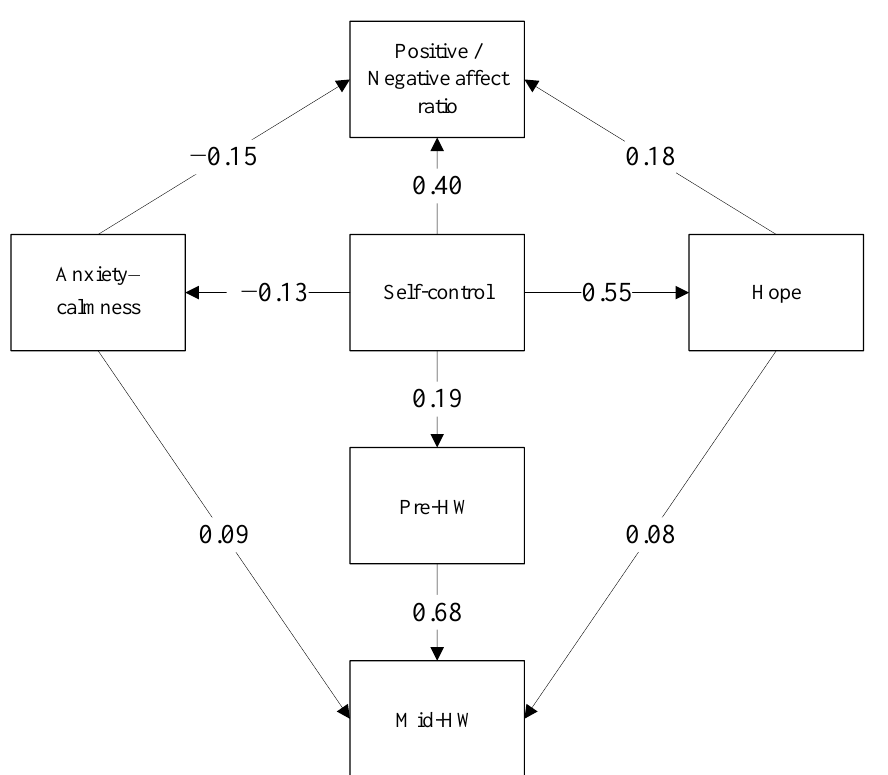
Figure 1. The mediation model linking self-control skills to personal resources, epidemic-related anxiety, and handwashing (HW) habits. Standardized regression weights are presented. All paths are significant.